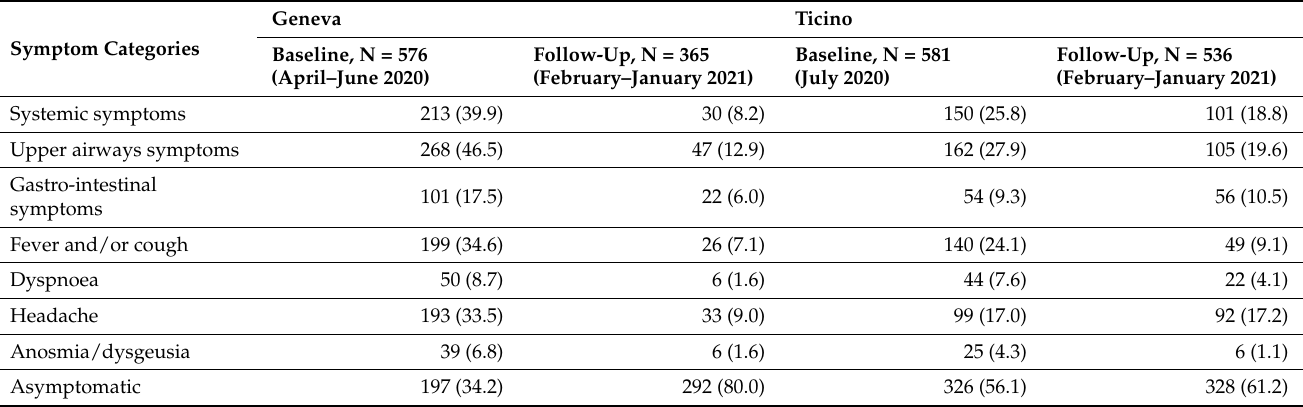
Table A3. Frequencies (percentages) of self-reported COVID-19-compatible symptom categories across studies and